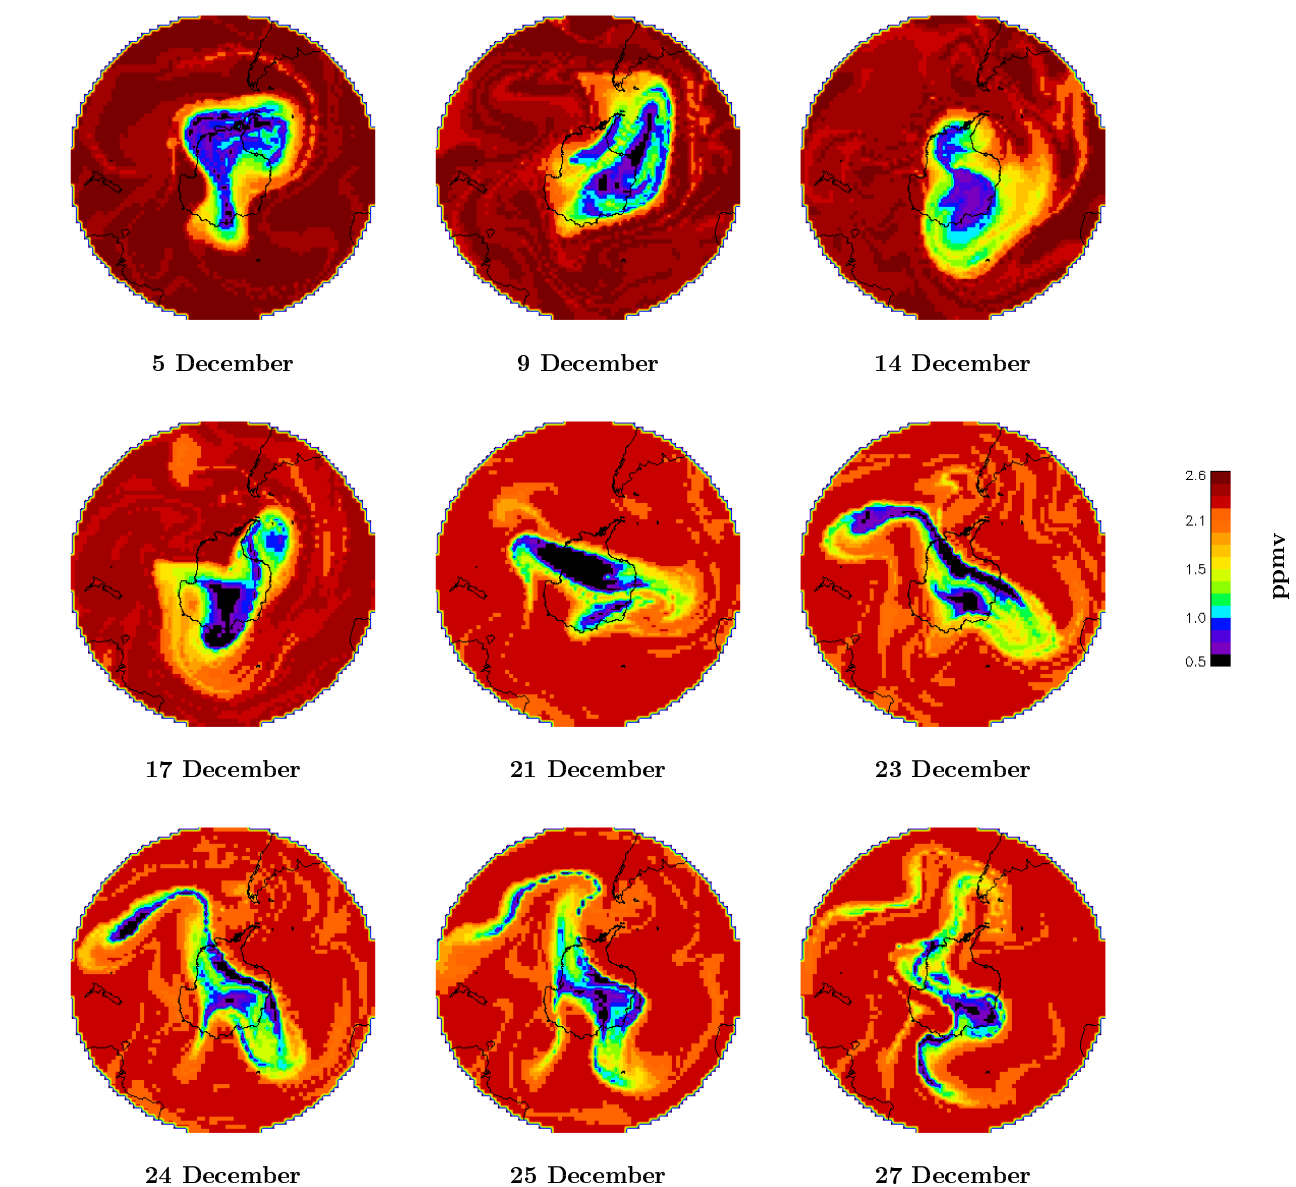
Fig. 6. Polar stereographic (30–90 ◦ S) high-resolution ozone maps on the 500K surface for nine selected days in December 1998.